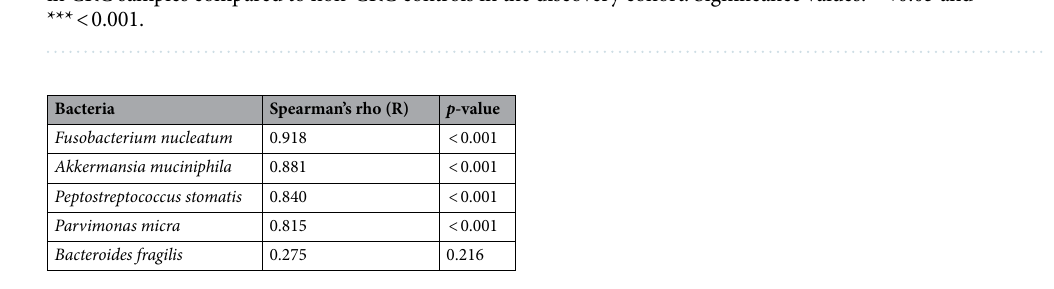
Table 4. Correlation between bacterial candidate marker abundance detected from sequencing and qPCR. Samples with no reads in sequencing and Cq > 35 in qPCR were excluded from the correlation analysis.